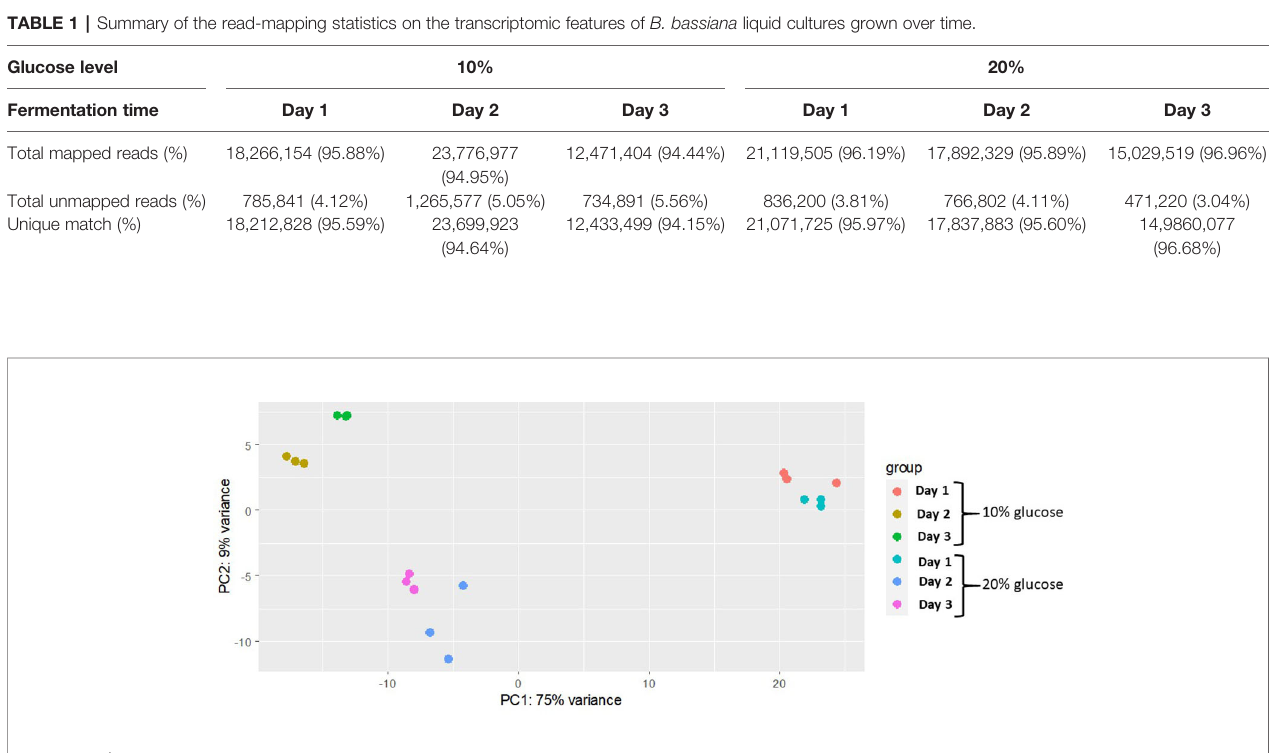
FIGURE 2 | Multivariate analysis separating glucose treatments across different fermentation time points. Principal component analysis of regularized-logarithmic (rlog) transformed gene counts of B. bassiana (strain GHA) blastospores cultivated in medium with 10% or 20% glucose during three days of growth. Biological replicates are represented by each dot (n = 3 per